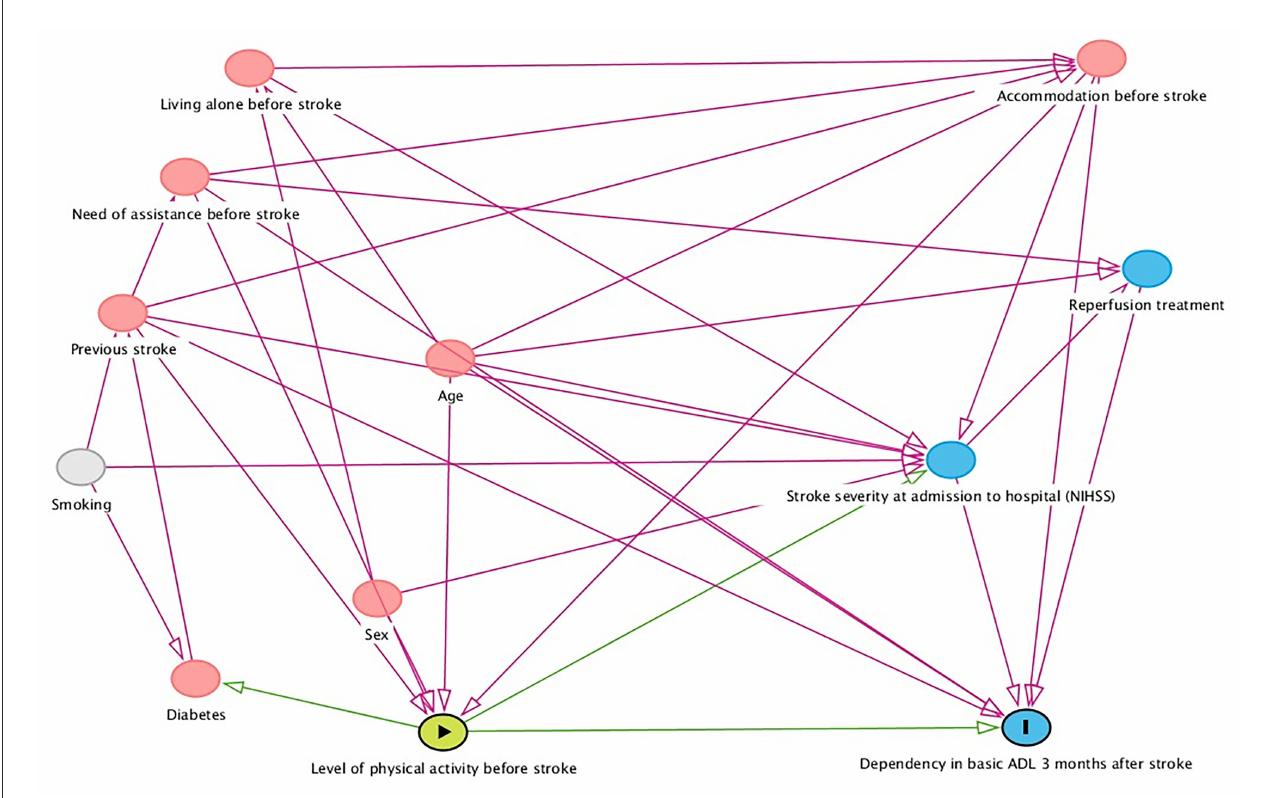
FIGURE1 Directed acyclic graph showing factors that might confound the relationship between level of physical activity before stroke and dependency in basic activities of daily living (ADL) 3 months after stroke. NIHSS, National Institutes of Health Stroke